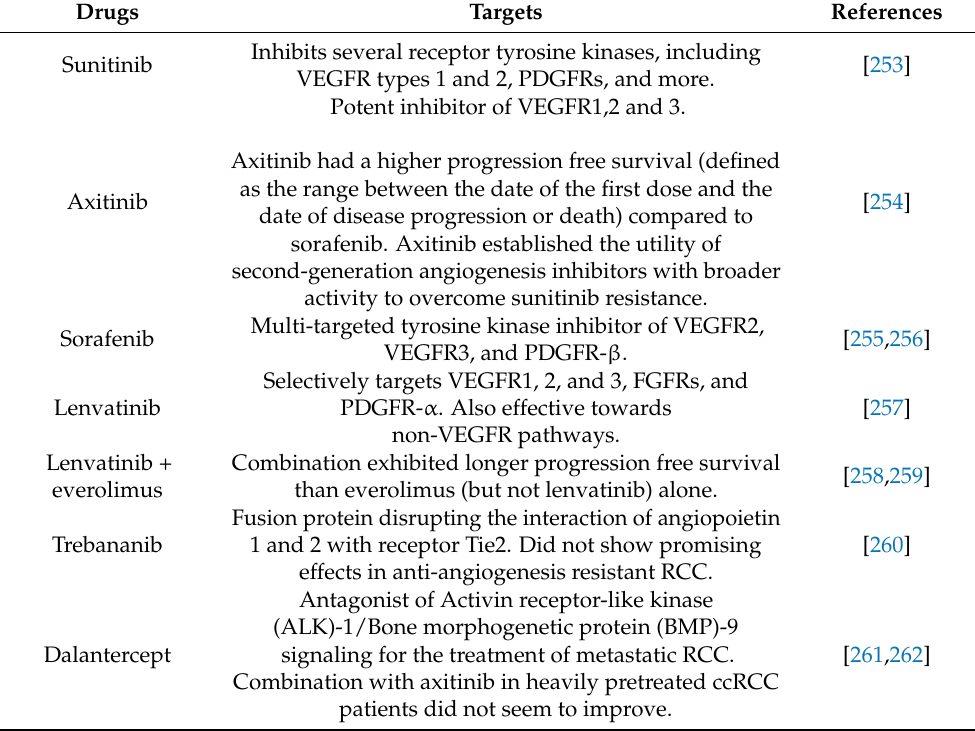
Table 5. Drug treatments for